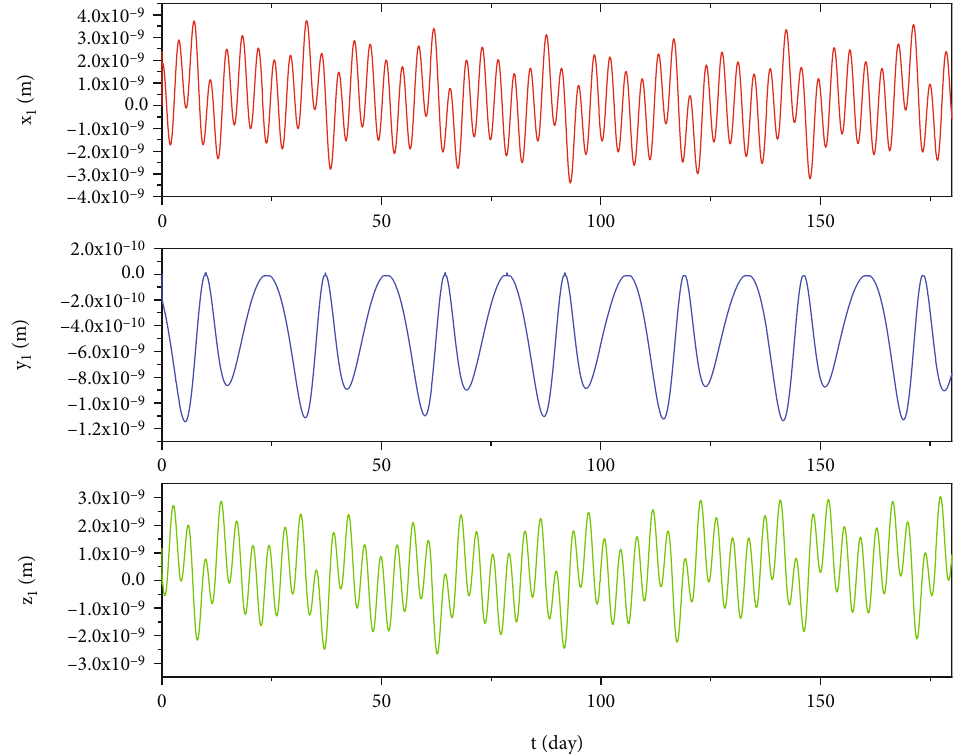
Figure 8: The control e ff ect of relative motion in the time